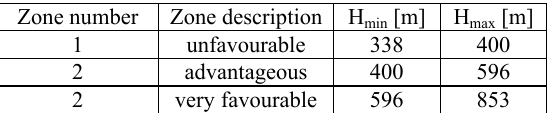
Table 1. Height range of zones